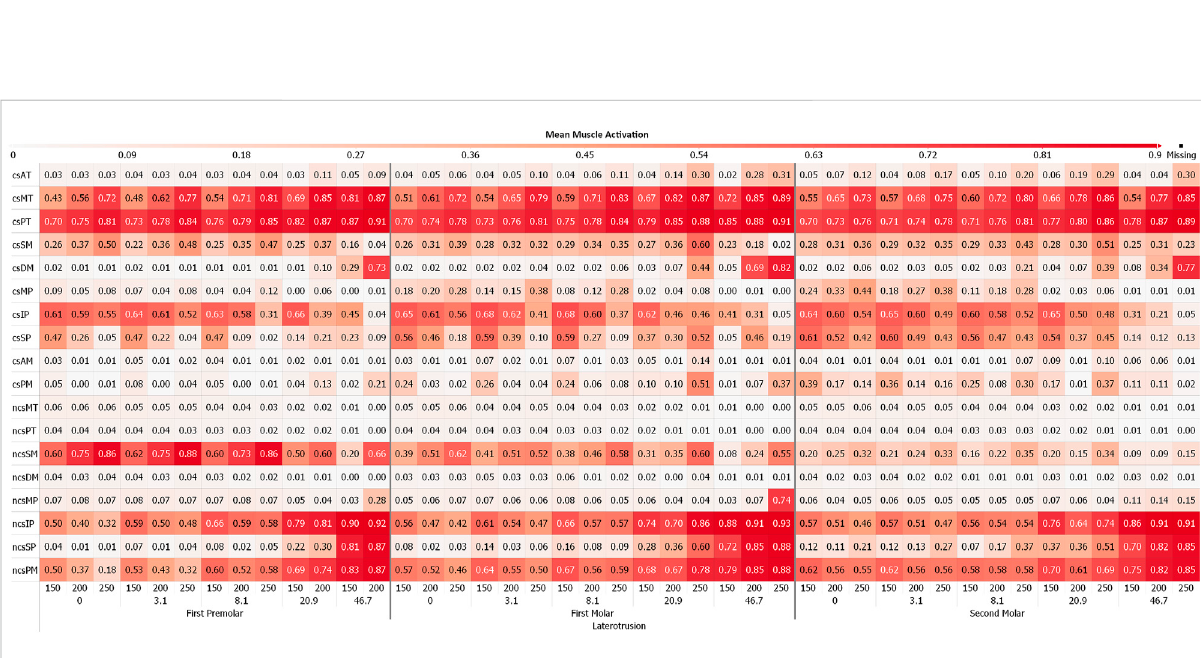
FIGURE 5 Mean muscle activation for all muscles with an activation > 20% for laterotrusive movements; 0, 3.1, 8,1, 20.9 and 46.7 are tooth facet inclinations in degree; 150, 200 and 250 are the bruxing force levels in Newton; contact side (cs) and non-contact side (ncs); AT, anterior part of temporalis; MT, medial partof temporalis; PT, posterior partoftemporalis; SM, super fi cialhead ofthemasseter;DM, deep headof themasseter; MP, medial pterygoid; IP, inferior head of lateral pterygoid; SP, superior head of lateral pterygoid; AM, anterior mylohyoid; PM, posterior